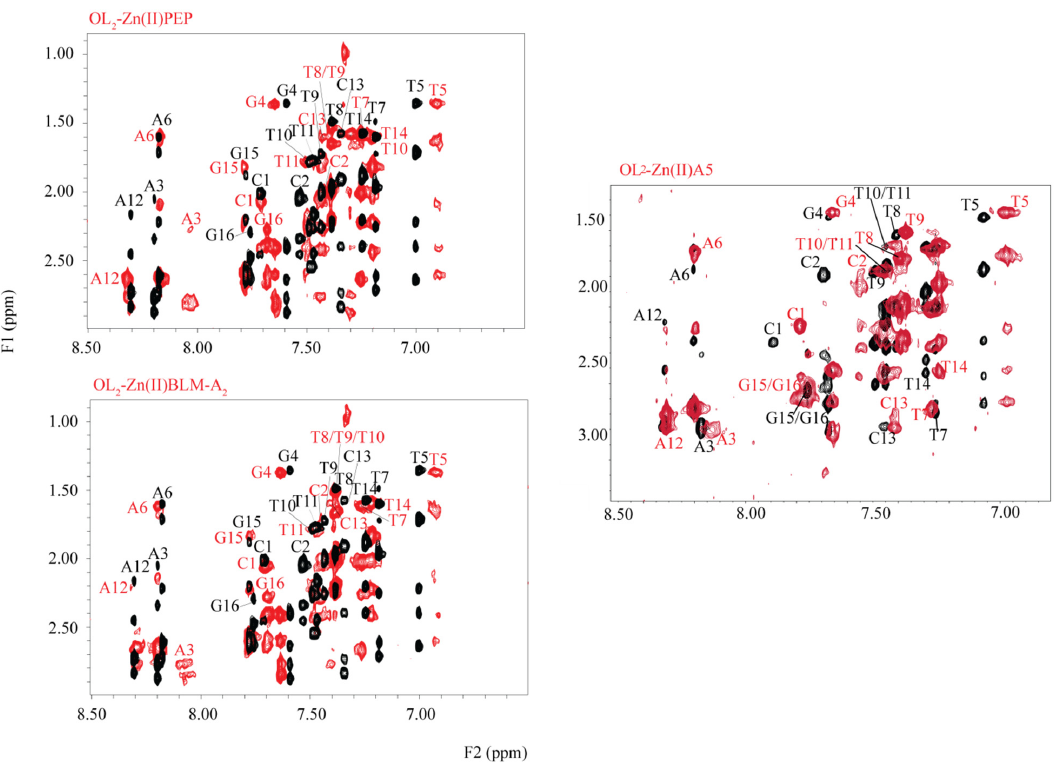
Figure 7. Overlays of the base regions of the NOESY spectra for samples in D 2 O acquired at 25 °C for free OL 2 ( black ) and Zn(II)BLM-bound OL 2 ( red ). Table 2. Chemical shifts of the base protons in free and Zn(II)BLMs-bound OL 2 for samples in D 2 O at 25 °C.